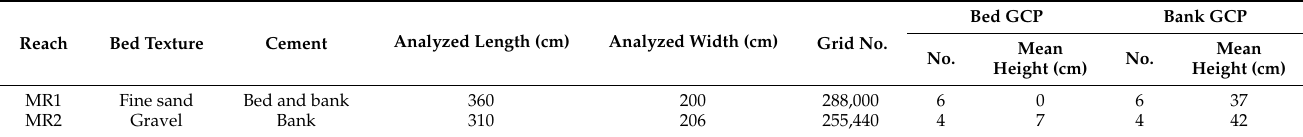
Table 1. Characteristics of the two monitored